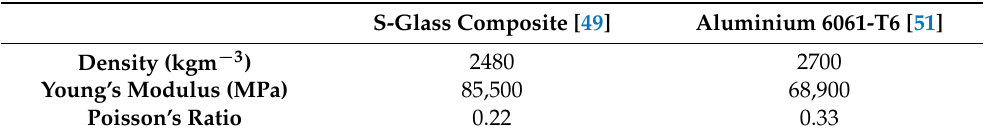
Table 7. Rocket Material Properties.